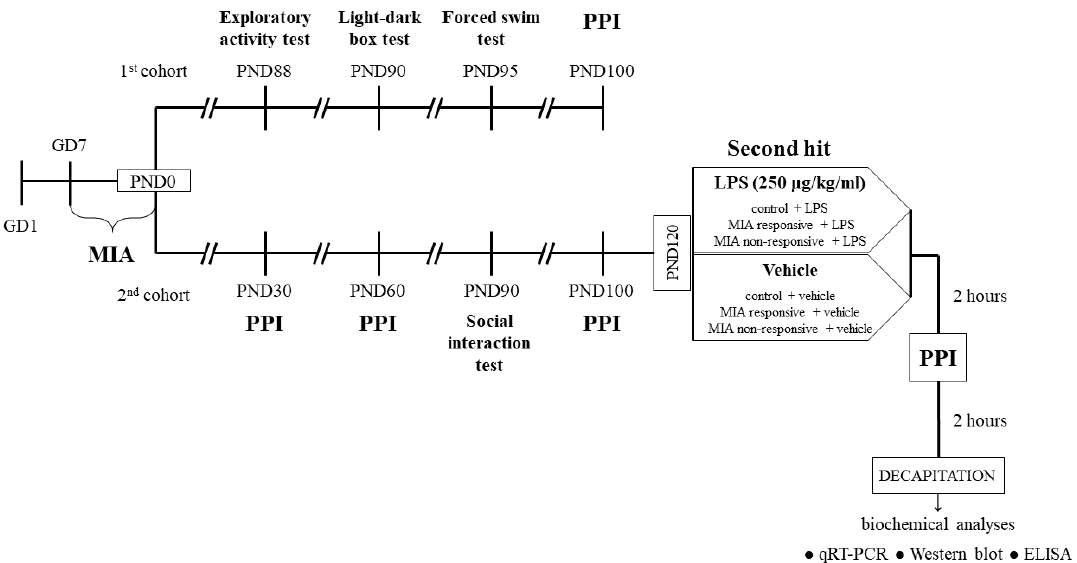
Figure 1. Experimental design. Pregnant dams were exposed to MIA with LPS (2 mg/kg in 1 mL, subcutaneously) beginning on the 7th (GD7) day of pregnancy and continuing every 2nd day until delivery. Control animals were subjected to vehicle (saline) injections on the same schedule. Twenty-one days after birth (PND21), male offspring were separated from dams and housed in groups of 5 per cage under standard conditions. Prior to further experiments, the rats were divided into 2 cohorts. The offspring from the 1st cohort (both the control and MIA groups) were used only for the behavioural examinations, including the exploratory activity test at PND88, light-dark box test at PND90, forced swim test at PND95 and PPI test at PND100. The animals from the 1st cohort were not included in the biochemical analyses. The offspring from the 2nd cohort (both the control and MIA groups) underwent the behavioural examinations in the following order: the PPI test at PND30 and PND60, the social interaction test at PND90 and the PPI test at PND100. At PND120, the animals were divided into 6 groups (control + vehicle, control + LPS, MIA responsive + vehicle, MIA responsive + LPS, MIA non-responsive + vehicle, MIA non-responsive + LPS) and were exposed to the second hit either with LPS (250 µg/kg in 1 mL, intraperitoneally) or vehicle (saline), according to the group assigned. Two hours later, the rats underwent the PPI test and after another 2 h, they were sacrificed by decapitation. The tissues (the frontal cortices and hippocampi) were collected for the biochemical analyses (qRT-PCR, Western blot and ELISA).